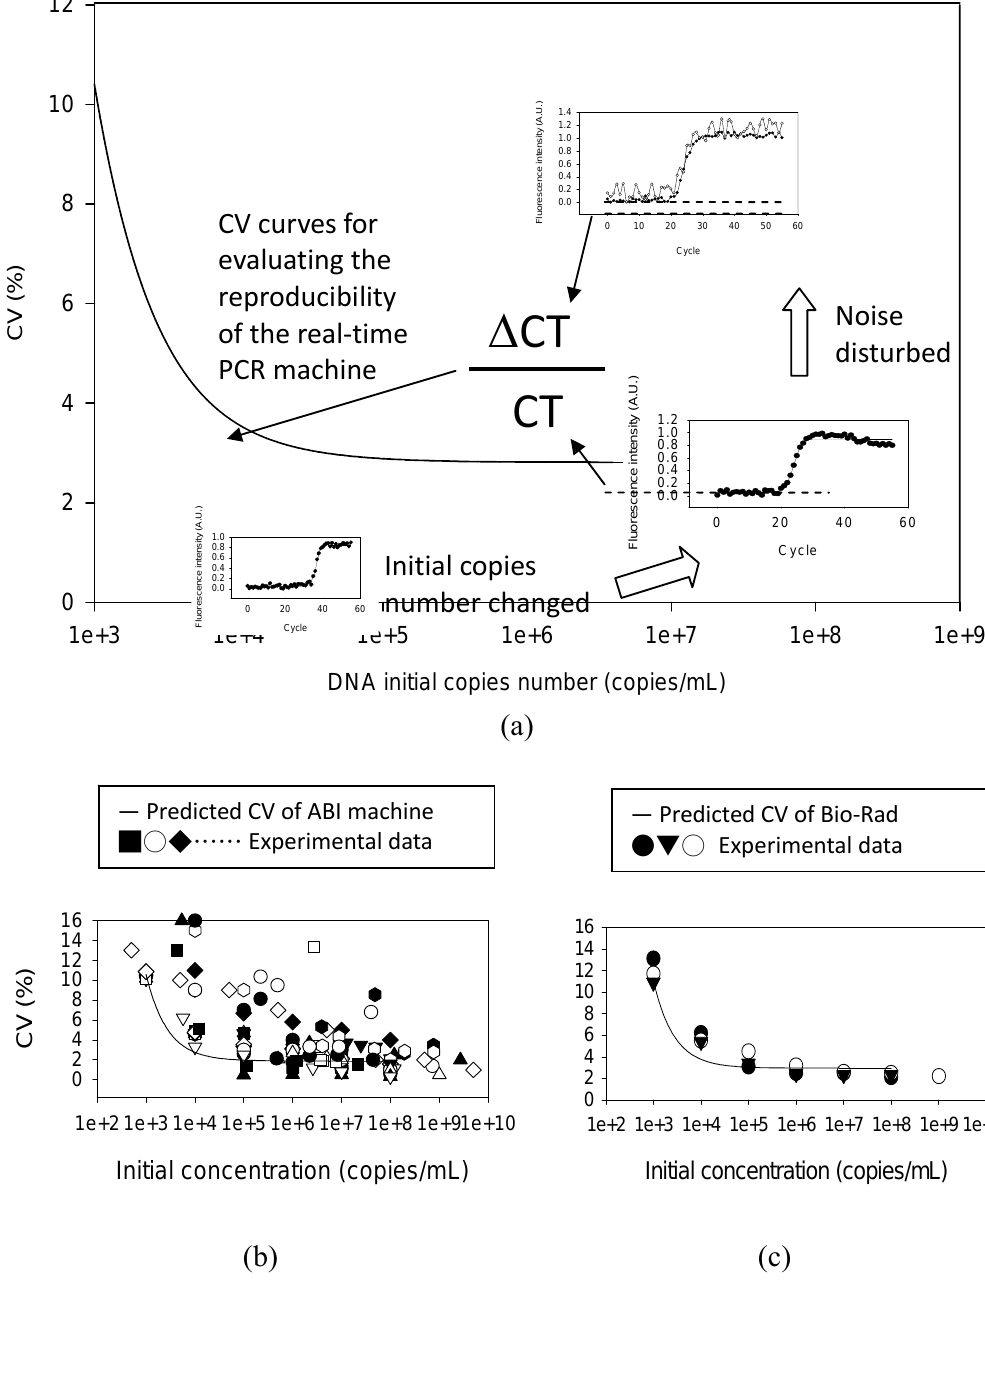
Figure 7. How to draw the coefficient of variation (CV) curves using the simulation results is illustrated in (a). The predicted CV of the ABI, Bio-Rad, Roche, and Rotor-Gene machines and their comparisons to the experimental data are shown in (b), (c), (d),